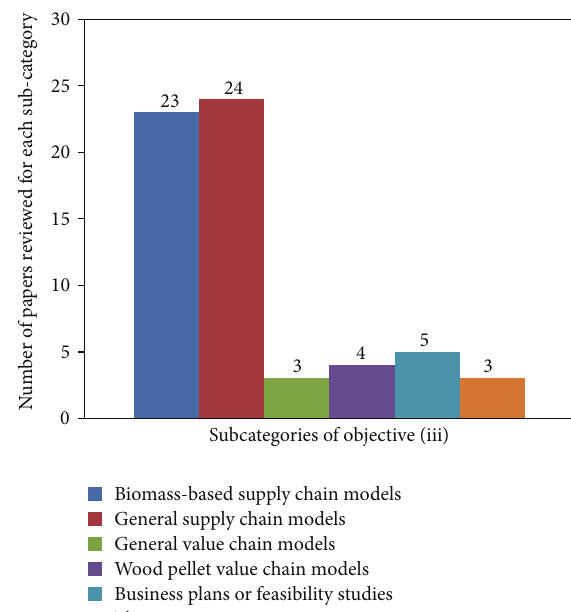
Figure 4: Publications reviewed for the subcategories of objective